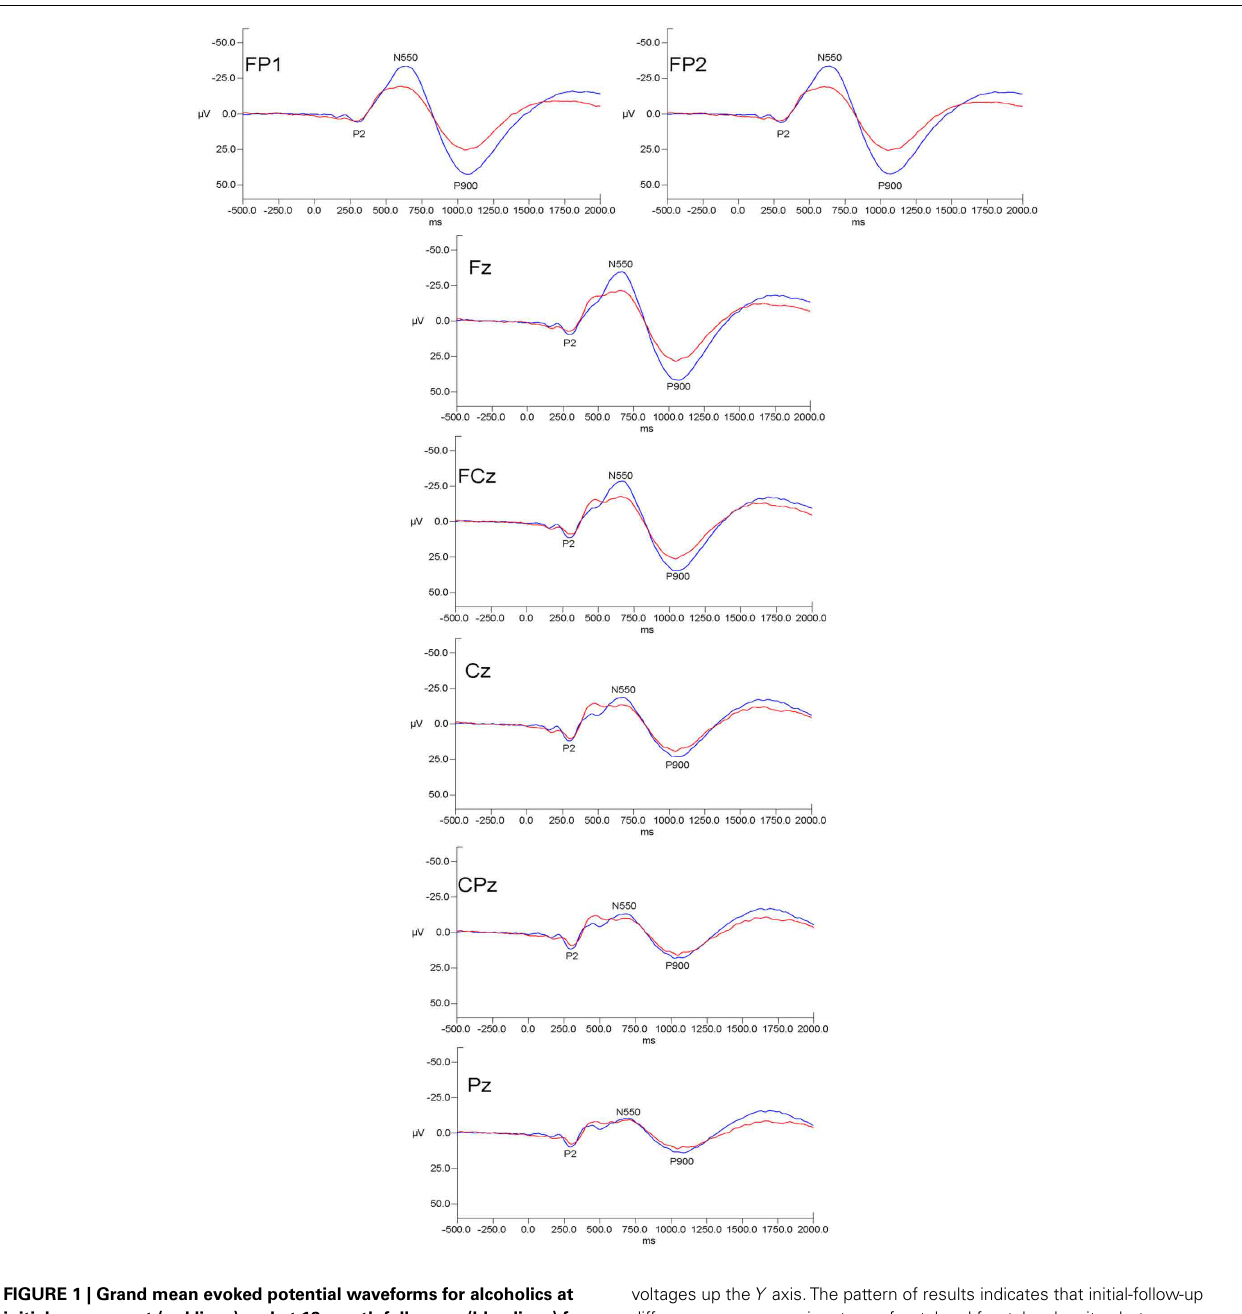
FIGURE 1 | Grand mean evoked potential waveforms for alcoholics at initial assessment (red lines) and at 12month follow-up (blue lines) for the seven measured electrode sites. Data are presented with negative